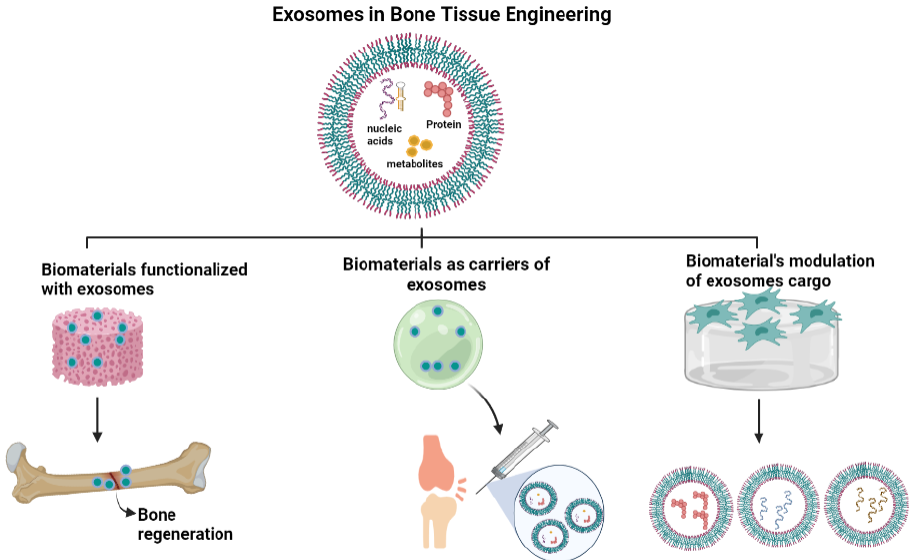
Figure 3. Exosomes in Bone Tissue Engineering. Studies of exosomes in Bone Tissue Engineering are grouped into 3 broad categories-1. Biomaterials functionalized with exosomes 2. Biomaterials as carriers of exosomes 3. Modulation of exosome cargo by biomaterials.